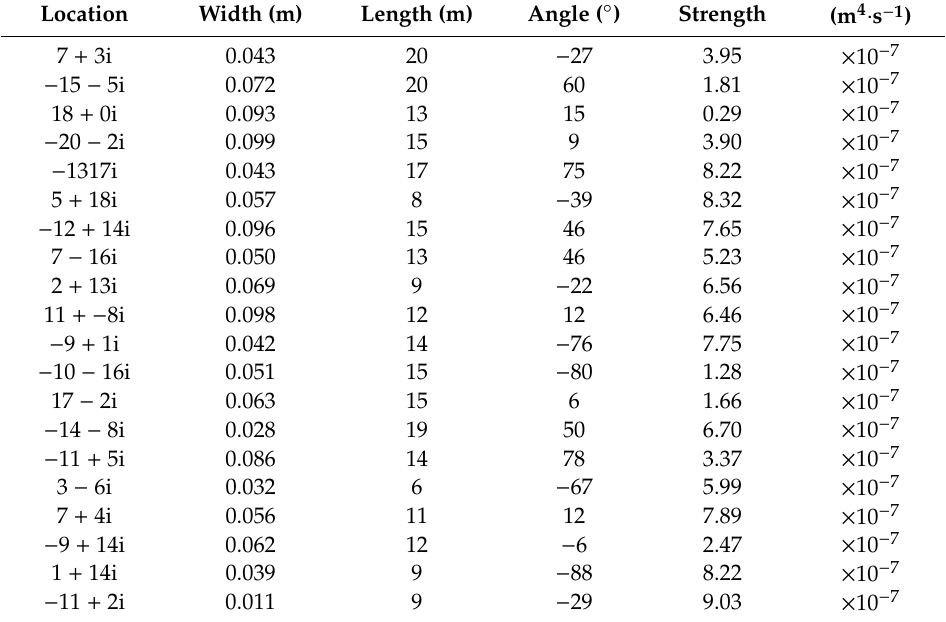
Table A5. Attributes of narrow synthetic flow channels (Case